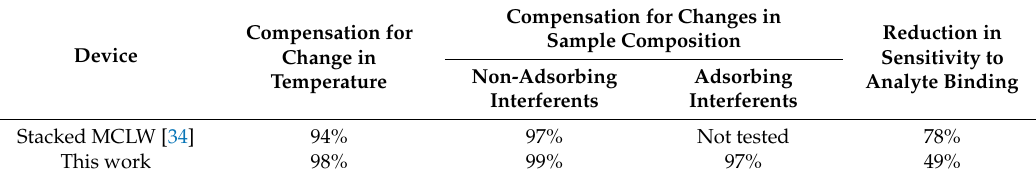
Table 2. Comparison of our previous work using stacked metal-clad leaky waveguide (MCLW) layers and this work using side-by-side sensing and reference strips.